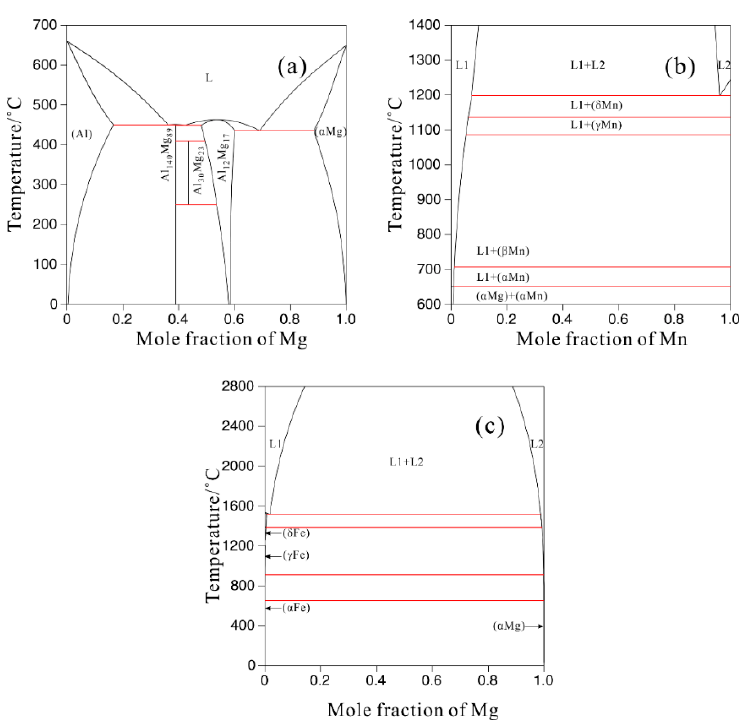
Figure 1. Calculated phase diagrams of binary systems based on the self-constructed Mg-Al-Mn-Fe database: ( a ) Al-Mg, ( b ) Mg-Mn, ( c ) Mg-Fe.